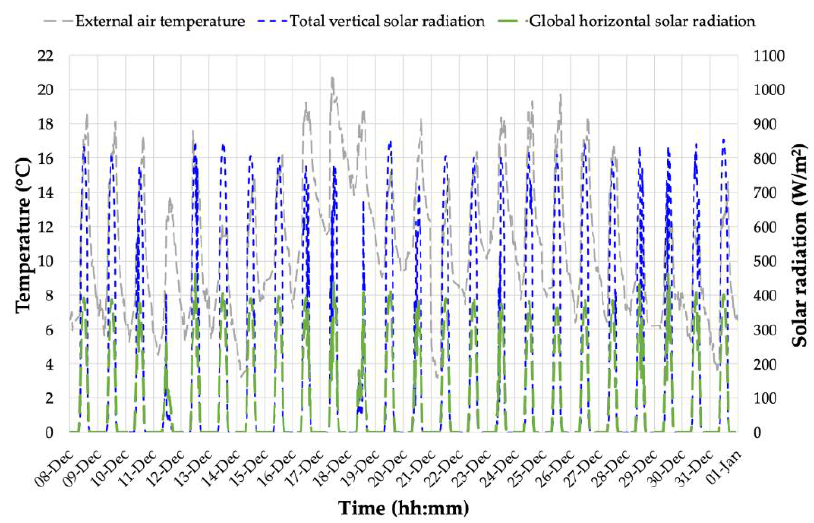
Figure 5. Overview of the whole winter acquisition period.